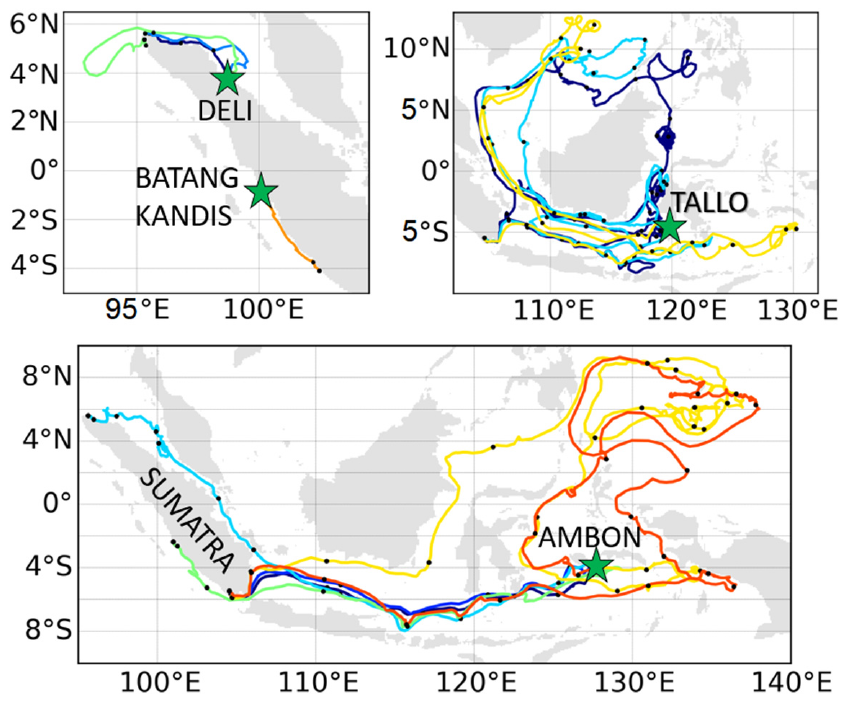
Figure 6. Examples of trajectories (in differentcolors per particle) of particle stranding along the western coast of Sumatra. Trajectory origins are indicated by green stars associated with the respective names of the rivers. Successive black dots illustrate 30-day intervals along each trajectory. The upper left panel shows the stranding location of locally released particles. The other two panels illustrate trajectories of particles with remote origins and long drifts.